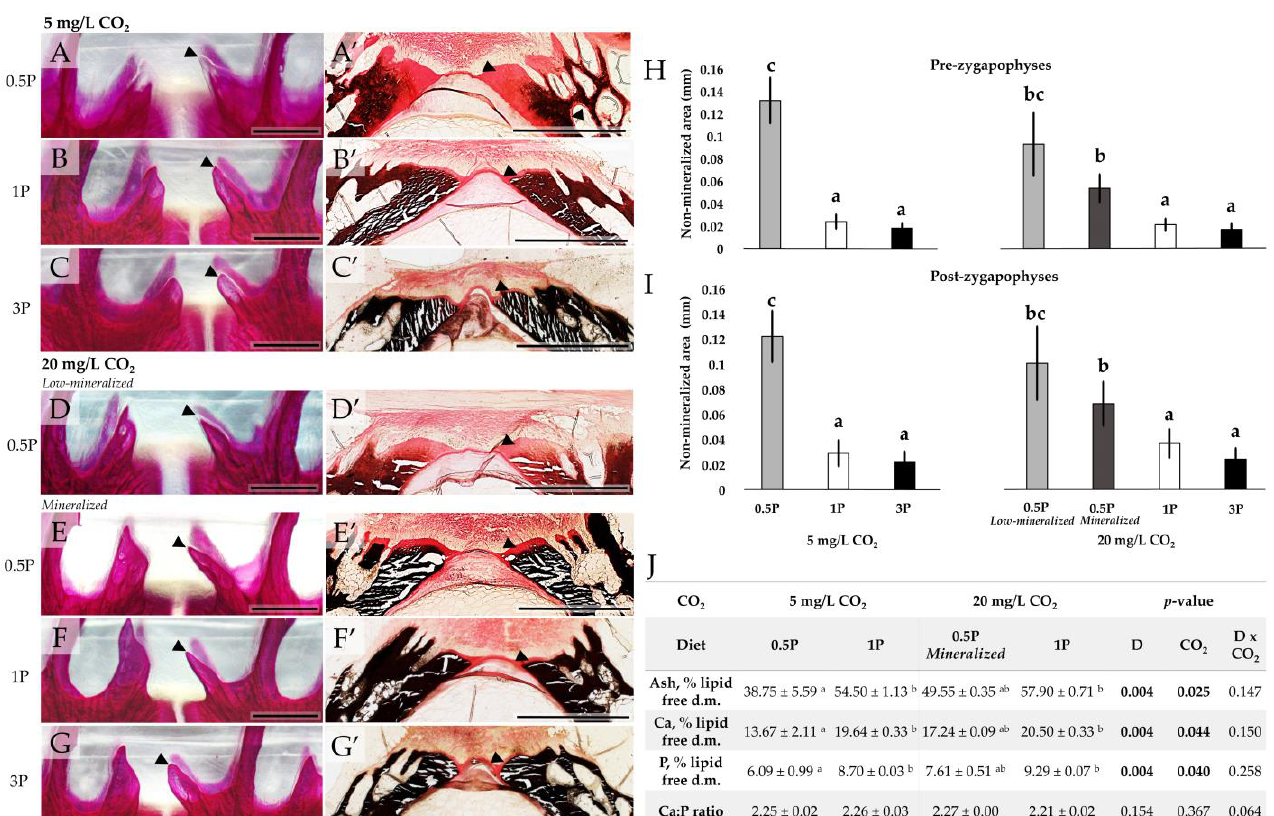
Figure 6. Mineralization pattern and Alizarin Red S mineral analysis. Whole mount Alizarin Red S stained ( A – G ) and non-demineralized sections ( A’ – G’ ) (von Kossa/Van Gieson), scale bar = 1 mm of representative vertebral bodies from animals fed different levels of total phosphorus (P) 0.5P (6.3 g/kg), 1P (9.0 g/kg), and 3P (26.8 g/kg) and reared in conditions with no CO 2 injected (5 mg/L) or with injected CO 2 (20 mg/L). Black arrowheads in ( A – G’ ) point to the areas of non-mineralized bone at the pre-zygapophyses ( A – G ) and at the vertebral body endplates ( A’ – G’ ). ( A – A’ ) Representative samples from animals fed 0.5P and reared in 0.5 mg/L CO 2 showing increased areas of non- mineralized bone at the zygapophyses and vertebral body endplates. ( E , E’ ) Representative samples from animals fed 0.5P and reared in 20 mg/L CO 2 showing reduced extent of the non-mineralized bone at the pre-zygapophyses and vertebral body endplates. Graphs show the extent of the non- mineralized area of bone at the pre-zygapophyses ( H ) and post-zygapophyses ( I ). Different letters indicate significant differences among the animal groups. Table shows bone mineral content analysis. The statistically significant differences among groups (within a row) are indicated by different lowercase superscript letters. If none of the letters are the same, differences are significant. The significant values ( p ) for CO 2 , diet (D), and their interaction are indicated. There was a trend of an increased ash, Ca, and P ( J ) in the vertebral column of animals reared in high CO 2 and fed increased dietary P content.